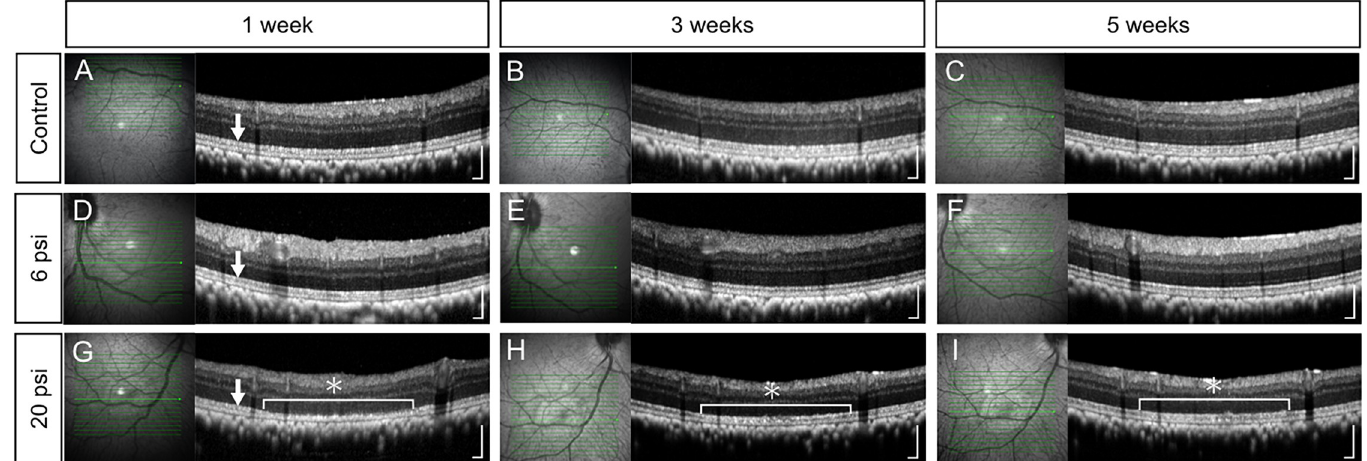
Fig 2. Optical coherence tomography images of monkey retina after subretinal injection of balanced salt solution. Optical coherence tomography (OCT) images of both control (no injection of balanced salt solution; BSS) and minimum-pressure (BSS injection at 6 psi) groups show a well-preserved retinal structure throughout the experimental period, including continuity of the ellipsoid zone (EZ) (A to F). OCT image from the high-pressure group (BSS injection at 20 psi) show EZ disruption (asterisk in G) at 1 week after the injection (G). At 3 weeks after the injection (H), OCT image from the high-pressure group shows partial recovery of the EZ (asterisk). The EZ finally became continuous (asterisk in I) at 5 weeks after the injection. Arrows in A, D, and G indicate the EZ. Scale bars = 200 μ m.